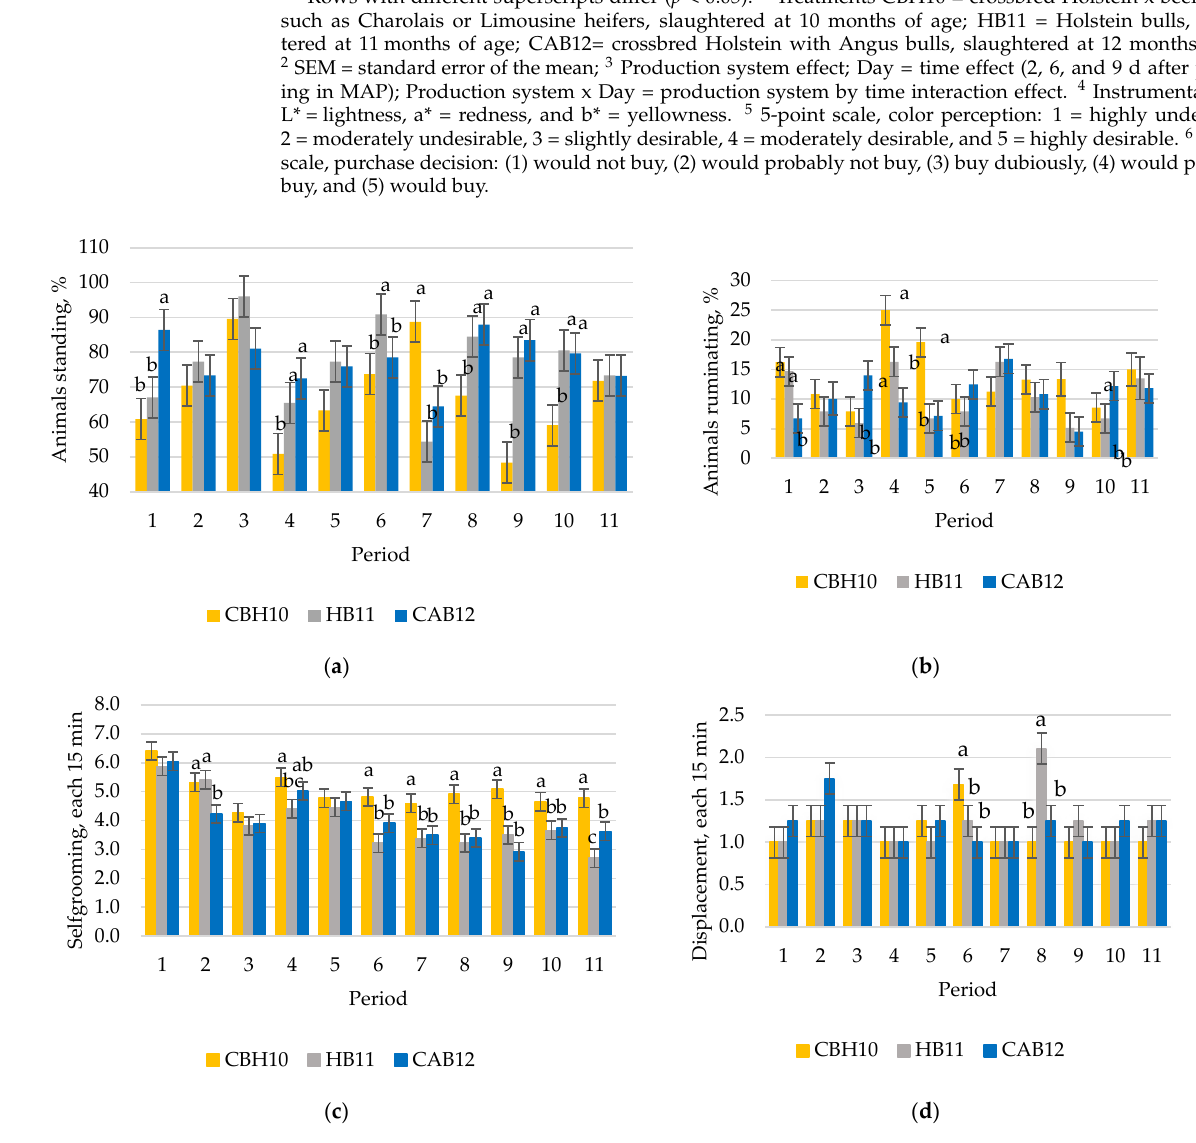
Figure 3. ( a ) Standing, ( b ) ruminating, ( c ) self-grooming, and ( d ) displacement behavior during the first 168 days of study in crossbred Holstein x beef breeds such as Charolais or Limousine heifers, slaughtered at 10 months of age (CBH10); Holstein bulls, slaughtered at 11 months of age; (HB11) and crossbred Holstein with Angus bulls, slaughtered at 12 months of age (CAB12) ( a,b,c significant differences ( p < 0.05) between production system within the same